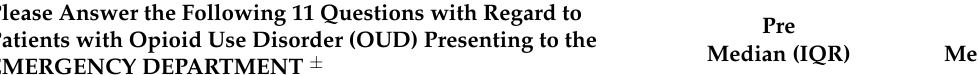
Table 2. Pre- and Post-Training Biases Around Patients with OUD ( n =